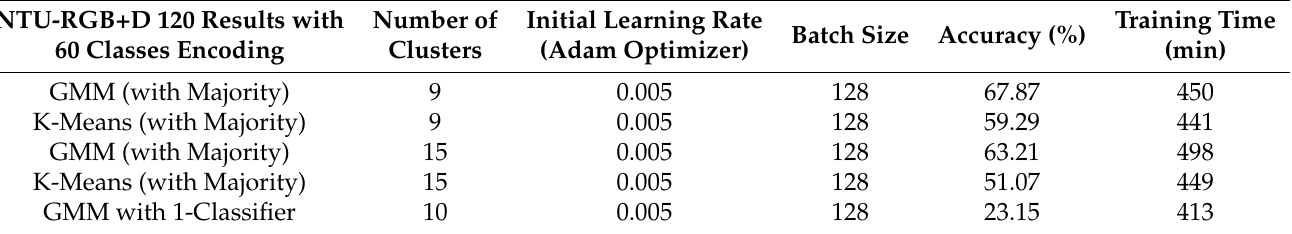
Table 8. NTU-RGB+D 120 results with 60 classes